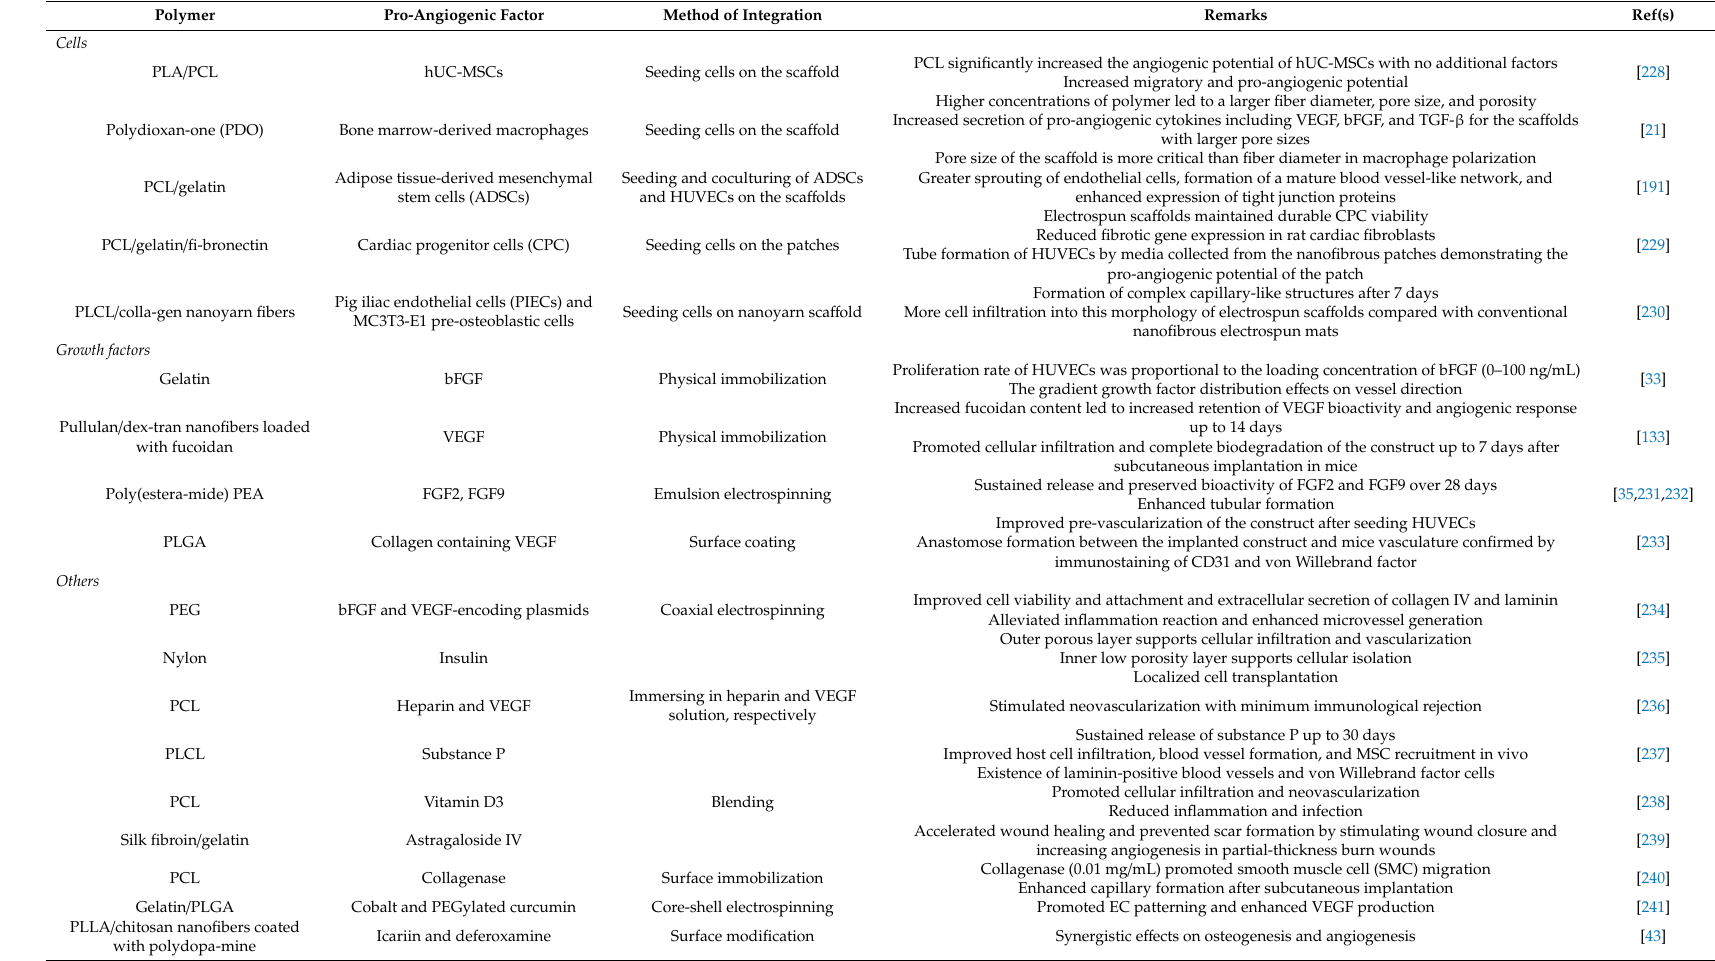
Table 5. Some examples of experimental studies in which pro-angiogenic factors were integrated into nanofibrous sca ff olds. MSC, mesenchymal stem cell; PLGA, poly(lactic-co-glycolic acid); PEG, polyethylene